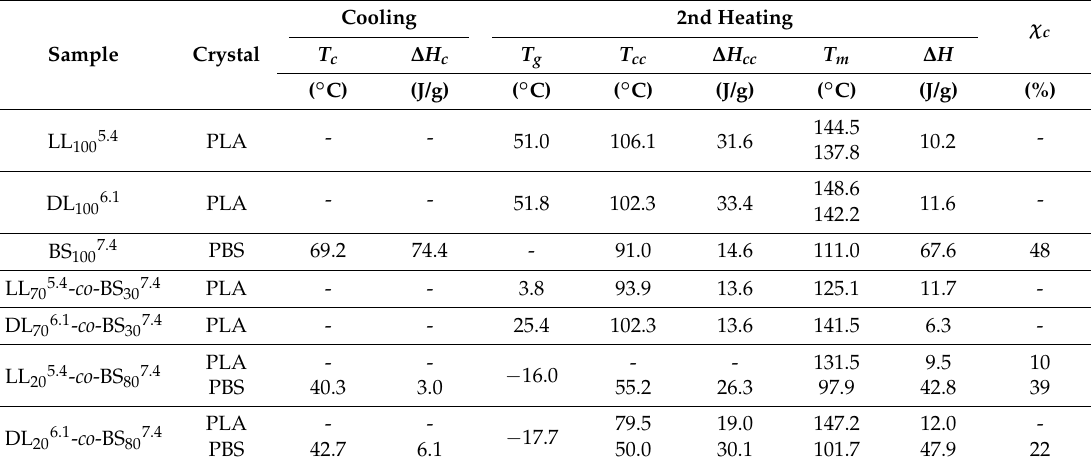
Table 4. Enthalpy of fusion, glass transition, and melting temperature for the homopolymer and copolymers indicated, during the first heating, cooling, and second heating at 20 °C/min.